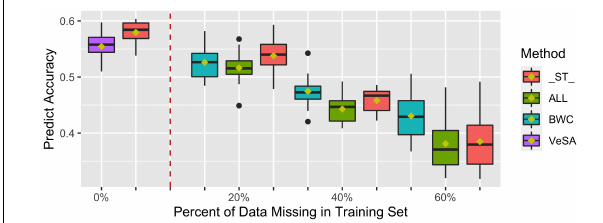
FIGURE 4 | Prediction accuracy from ST-GBLUP and MT-GBLUP models from the first cross-validation (CV1) scenario in temperate zone. Method “_ST_” is the ST-GBLUP model; Method “ALL” is a multi-trait model with all the three dry-down-related traits set to missing for an additional 20, 40, and 60% of the training set; Method “BWC” is a multi-trait model where only the phenotype for BWC is missing for an additional 20, 40, and 60% of the training set; Method “VeSA” is a multi-trait model with complete phenotypic data for all traits in the training set. The results to the left of the dashed lined had no missing data for any trait in the training